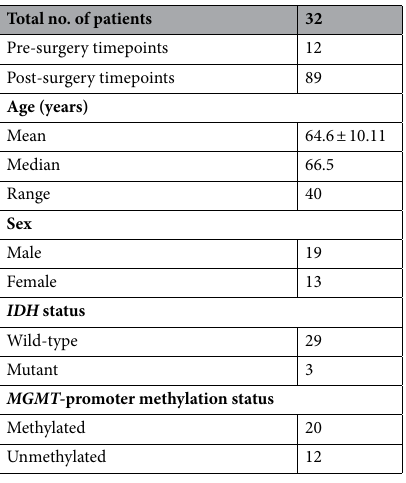
Table 1. Patient